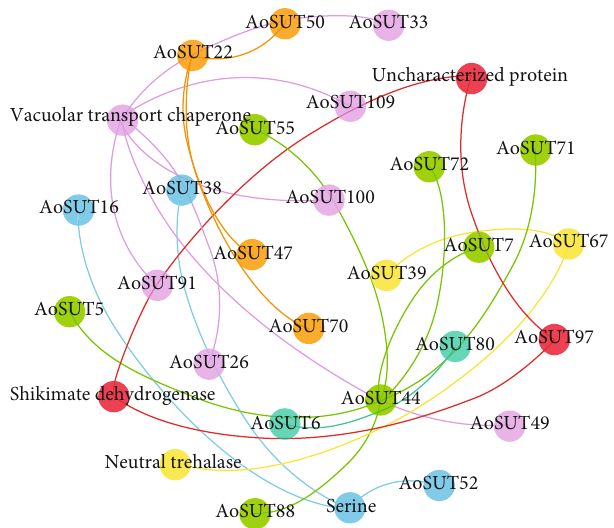
Figure 8: A protein-protein interaction (PPI) network of A. oryzae sugar transporter. The nodes represent proteins, and the edges represent the corresponding PPI. The con fi dence score was required to be greater than